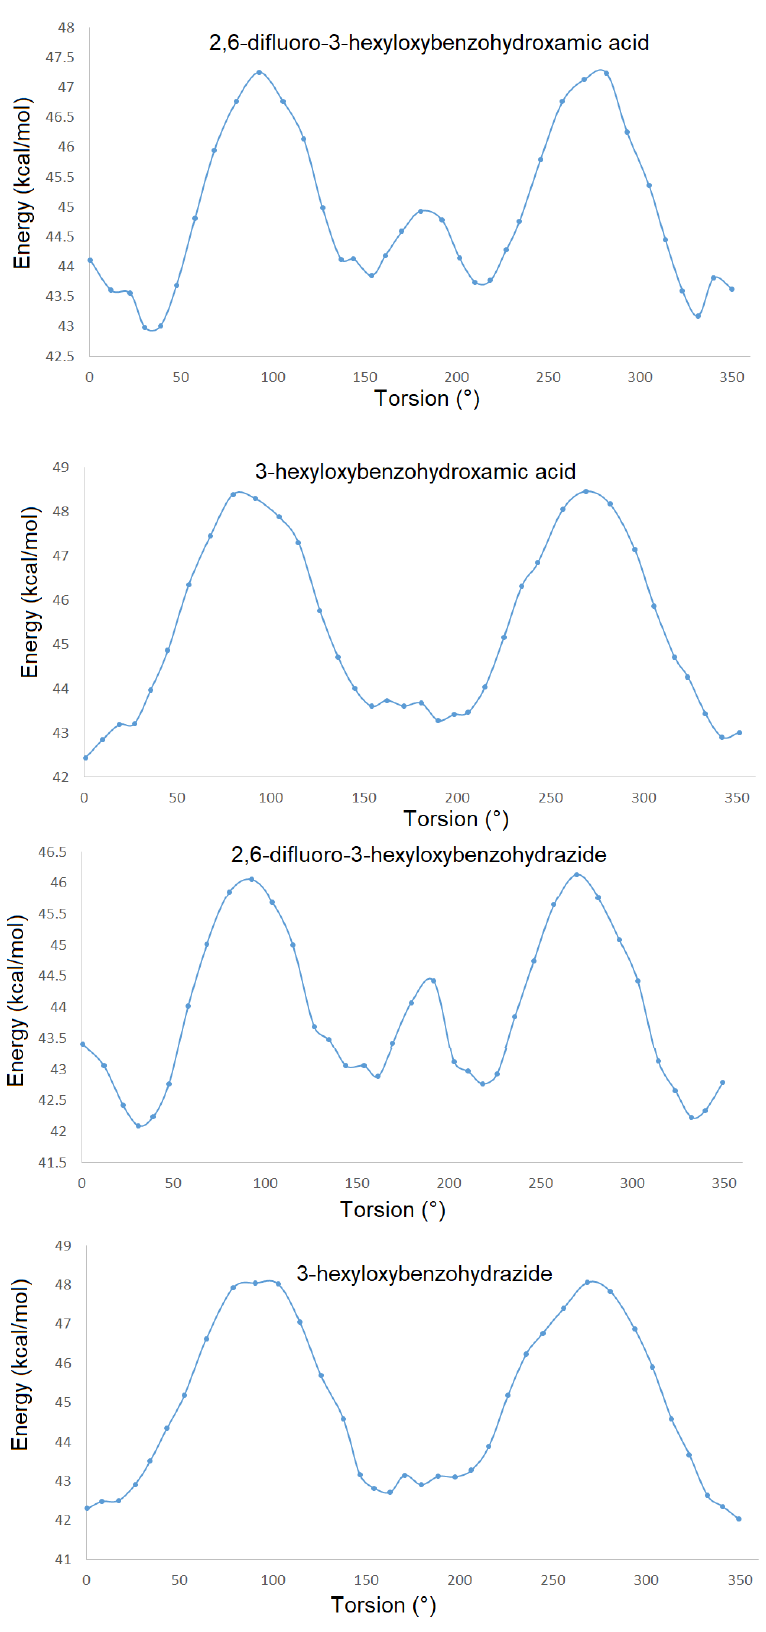
Figure 6. Conformational analysis of fluorinated or non-fluorinated 3-hexyloxy-benzohydroxamic acid and 3-hexyloxy-benzohydrazide.